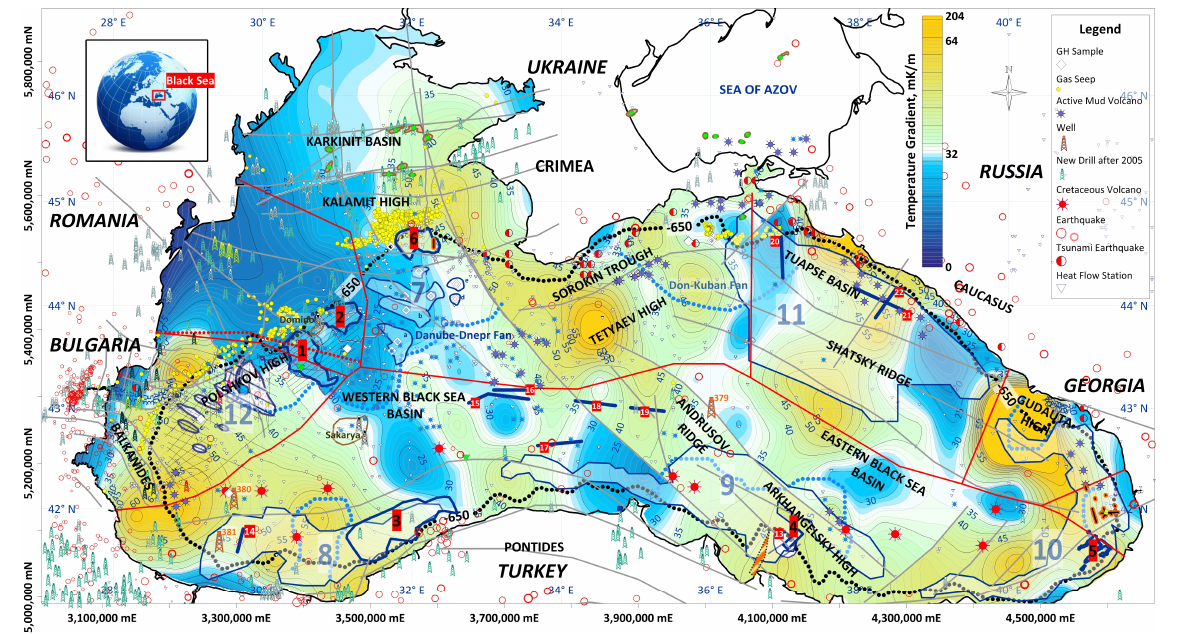
Figure 4. Black Sea geothermal gradient [28]. Data and objects from Figure 1.